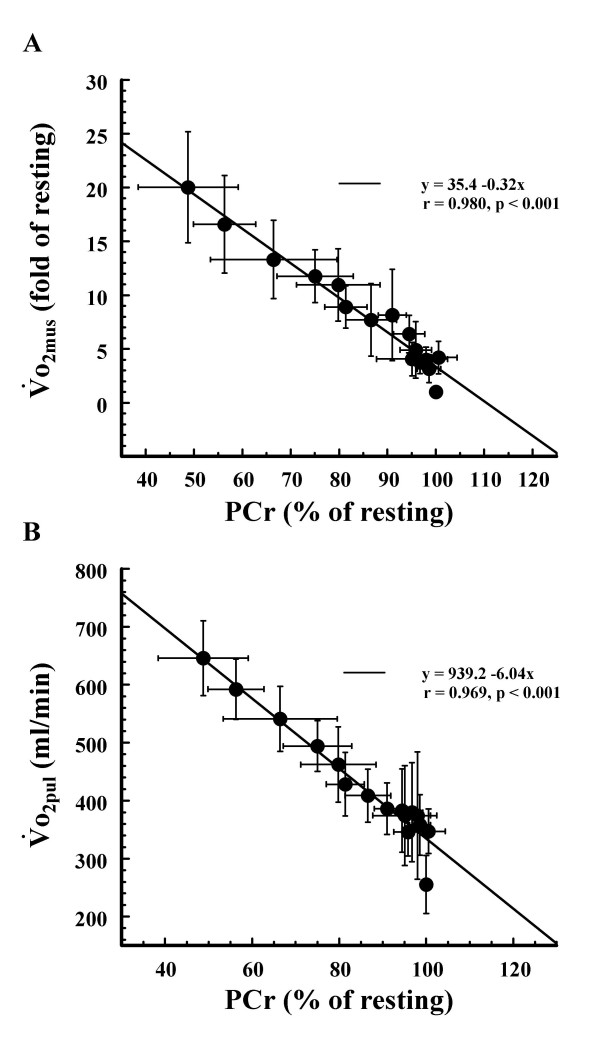
Relationships between muscle PCr and o2mus, muscle PCr and o2pul. Relationships between (A) averaged muscle PCr and o2mus and (B) averaged muscle PCr and o2pul. Values shown are means ± SD of 5 subjects.